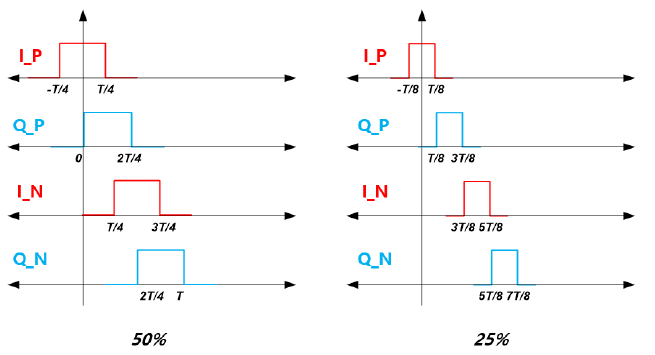
Figure 15. 50% and 25% duty cycles for differential I and Q phases of the mixer.